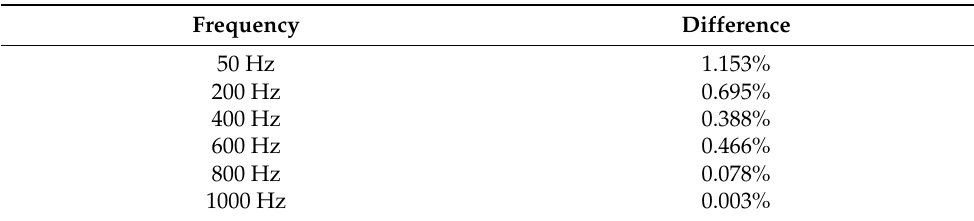
Table 4. Average difference between the CEV values attained with the CMOS image and the leakage current sensors for each